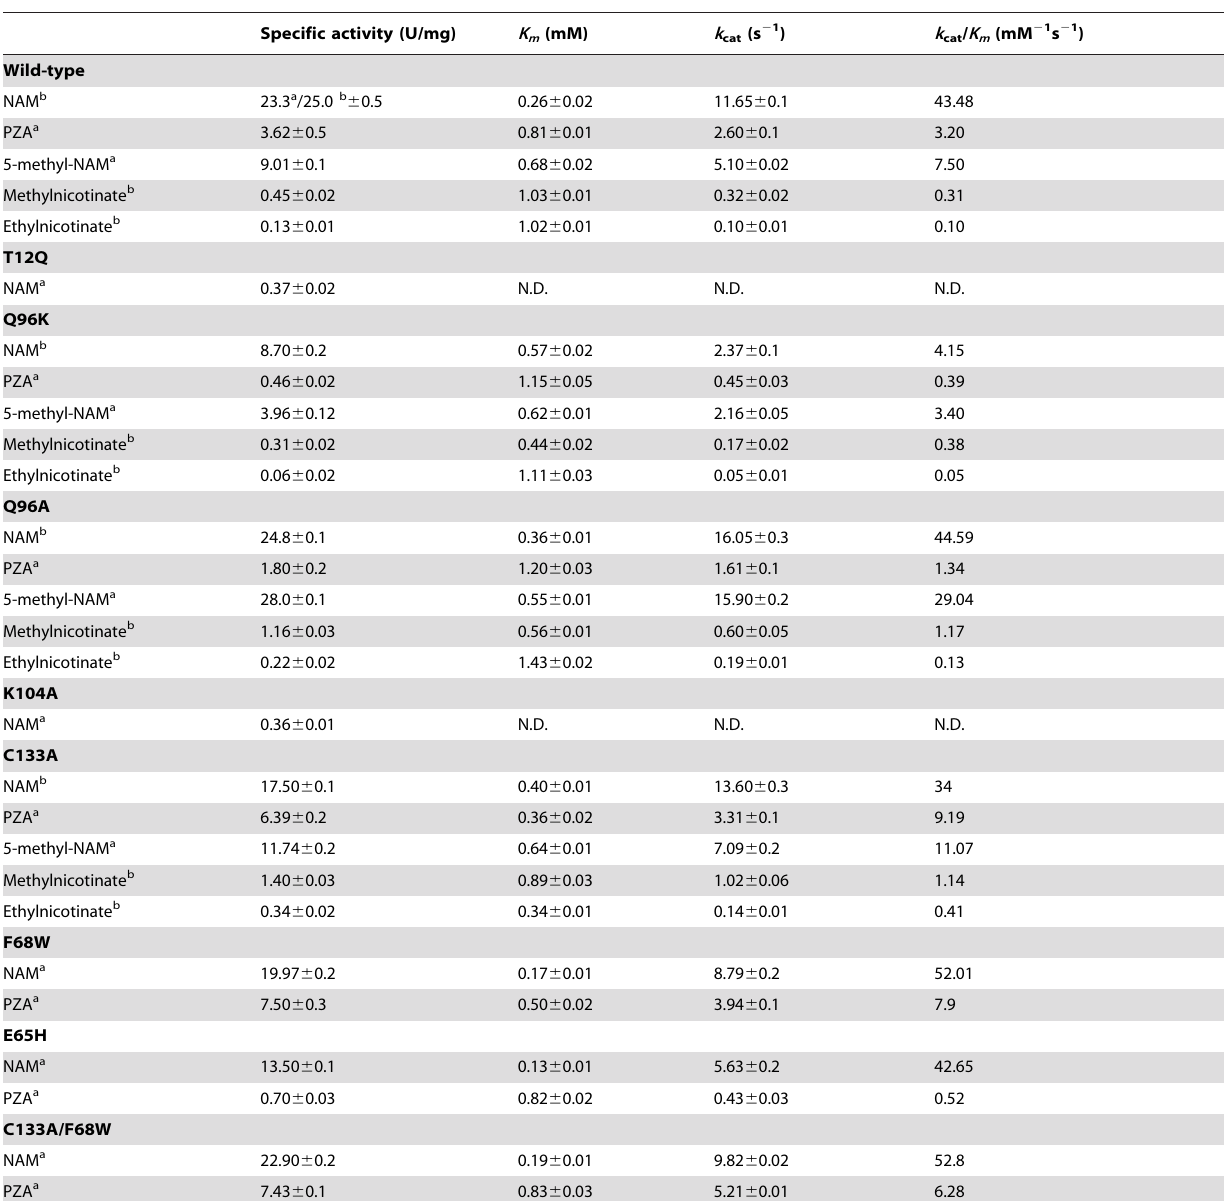
Table 1. Kinetic parameters of wild-type OiNIC and its